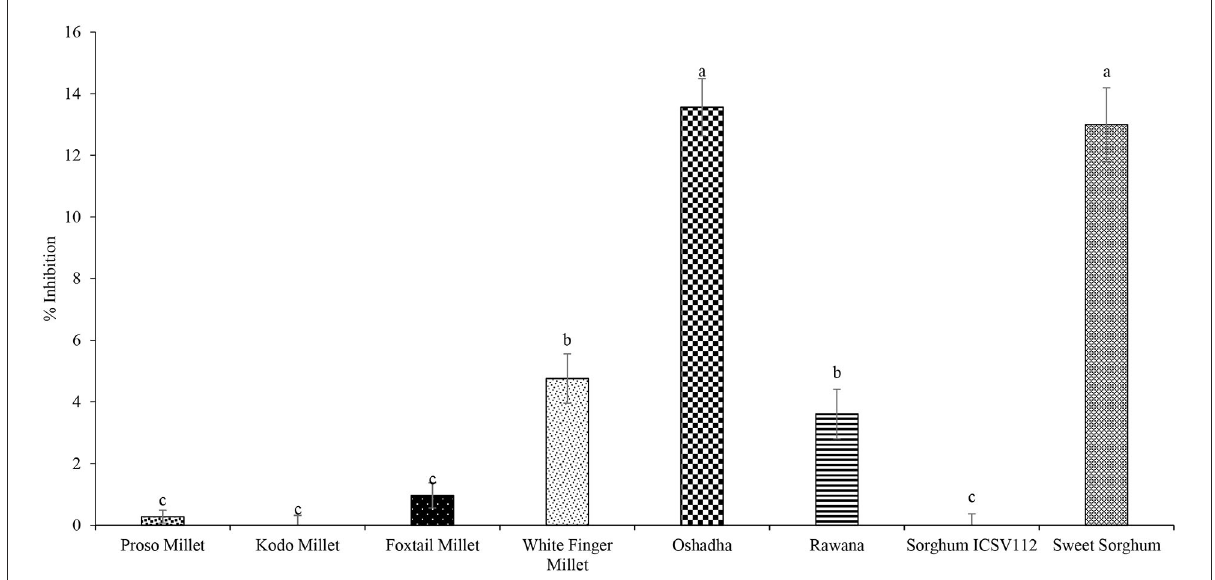
FIGURE4 Nitric oxide inhibitory activity of selected millet types and sorghum varieties at 2 mg/ml concentration. Different letters on bar graphs are significantly different at P < 0.05.